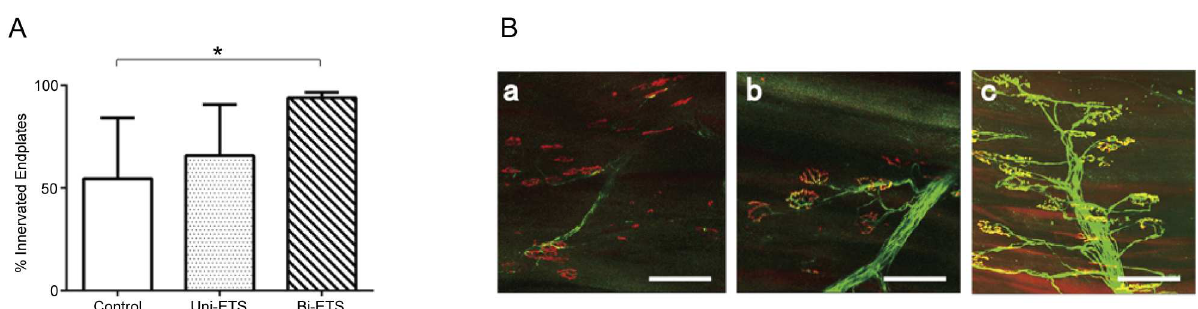
Fig 9. Motor reinnervation at Extensor digitorum longus (EDL) muscle. A) Percentageof reinnervatedendplateat 7 weeks after surgery (n = 4 per group). Quantitative analysisof endplateswithin 25 randomsamples in Thy1-yellow fluorescent protein 16 mice revealed that reinnervation was significantly better in the bilateralend-to-side (ETS) group than in the other groups ( * p < 0.05). B) Whole mount imagingof EDL muscle. a) In the control group, although the majority of motor endplatesremaineddenerved, a few regenerating axons were noted aroundthe endplate.b) The unilateralETS group showedthat a part of endplates were reinnervated. c) The bilateralETS group demonstrated that most of the endplateswere reinnervated and regenerated axons were well organized. Scale bar, 100 μ m.